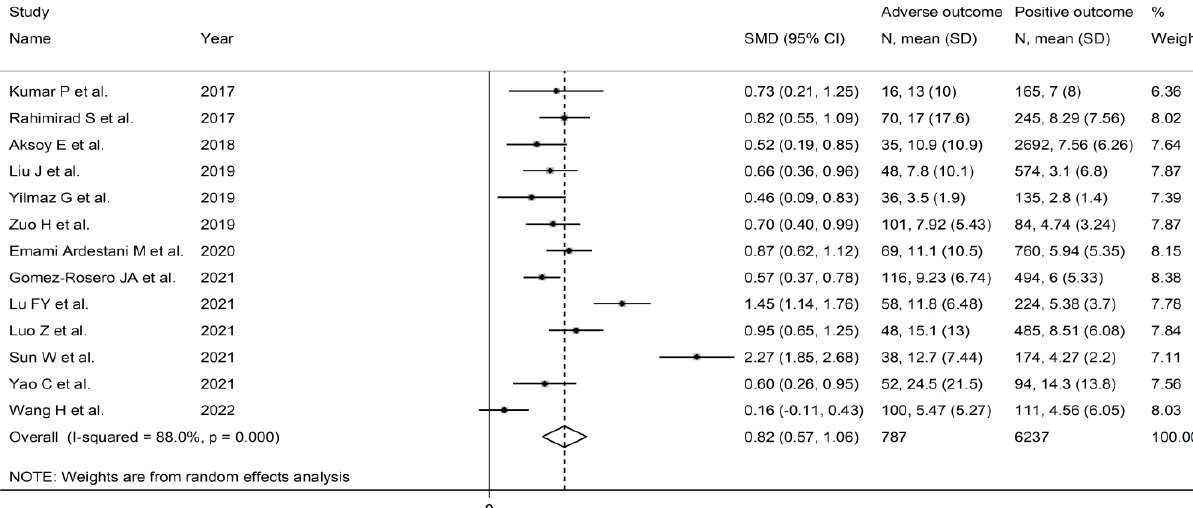
Figure 8. Forest plot of neutrophil-to-lymphocyte ratio values in AECOPD patients with and without adverse outcomes. p = 0.000 indicates a p -value < 0.001.